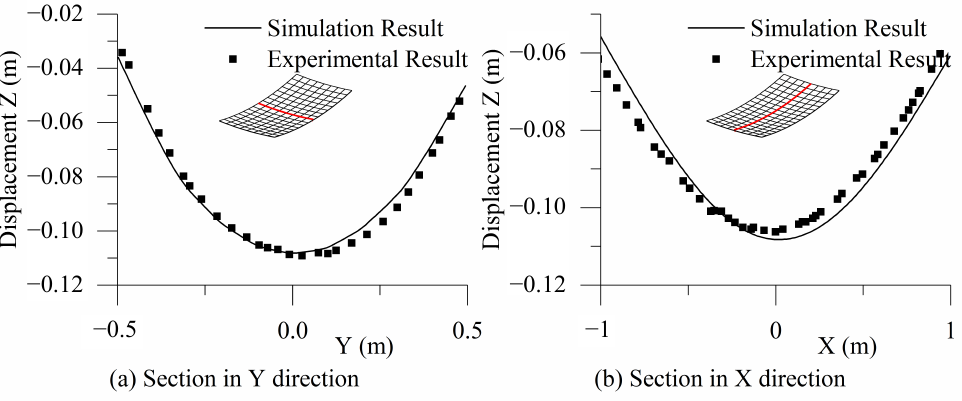
Figure 20. Displacement in Z direction along section ( a ) section in Y direction, ( b ) section in X direction.